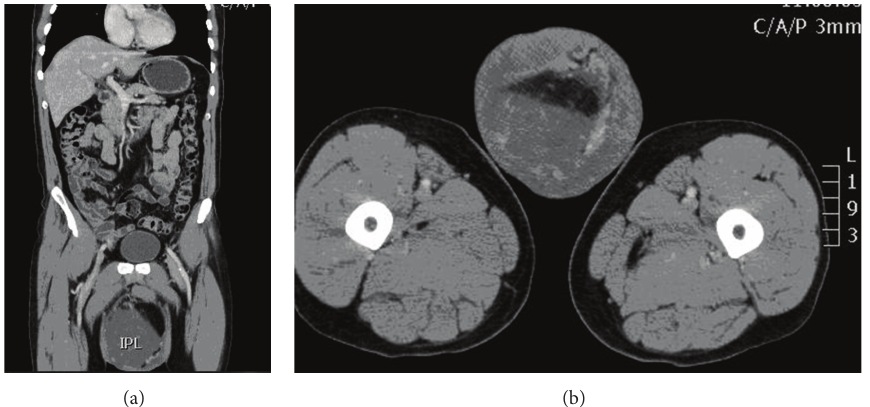
Figure 2: Coronal and axial views of CT abdomen and pelvis (a and b) showing the heterogenous mass with fat